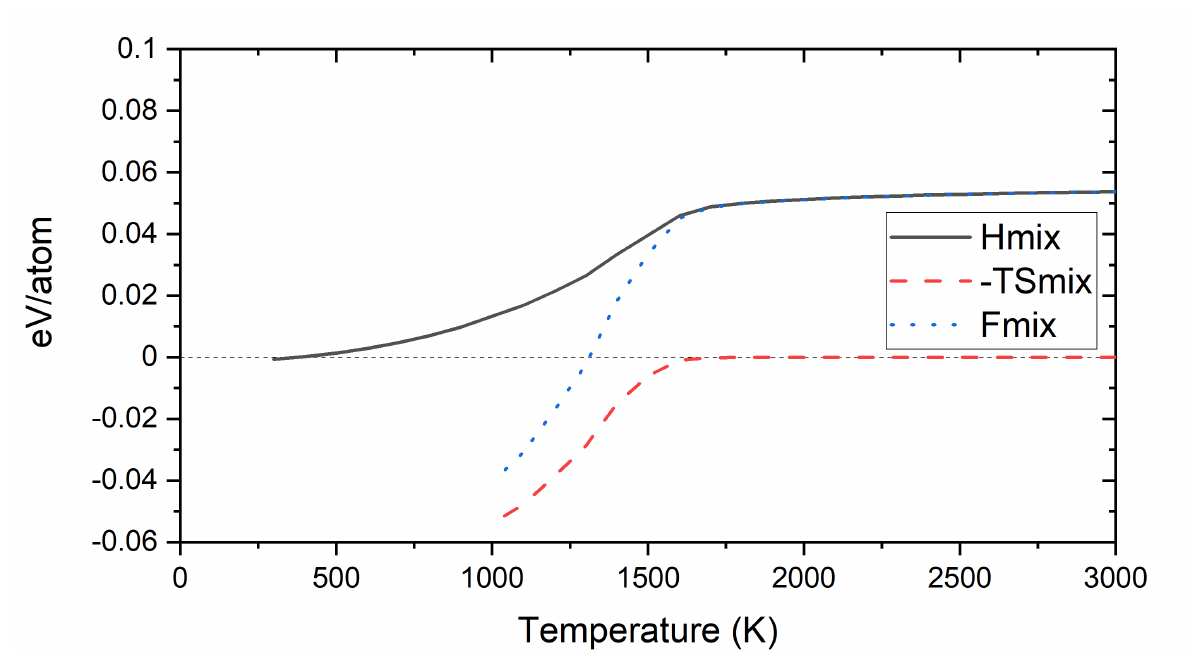
Figure 15. Free energy calculations from 1NN approximation for W 70 Cr 29 Ti 1